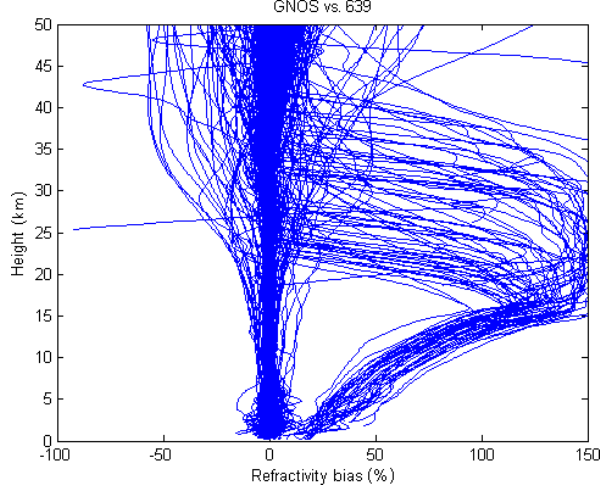
Figure 1. FY-3C GNOS GPS refractivity bias compared to T639 (the Chinese forecast model data) on 28 January 2017 with 489 sam-